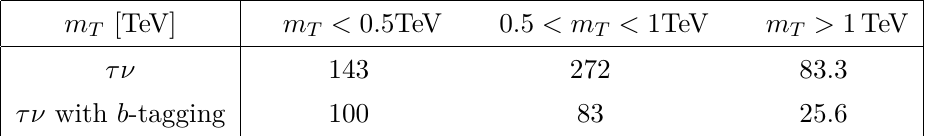
Table 3 . Our estimate of signal events for the benchmark model with C 23 √ luminosity of 35.9 fb − 1 at s =13 TeV, for the two analyses without and with b